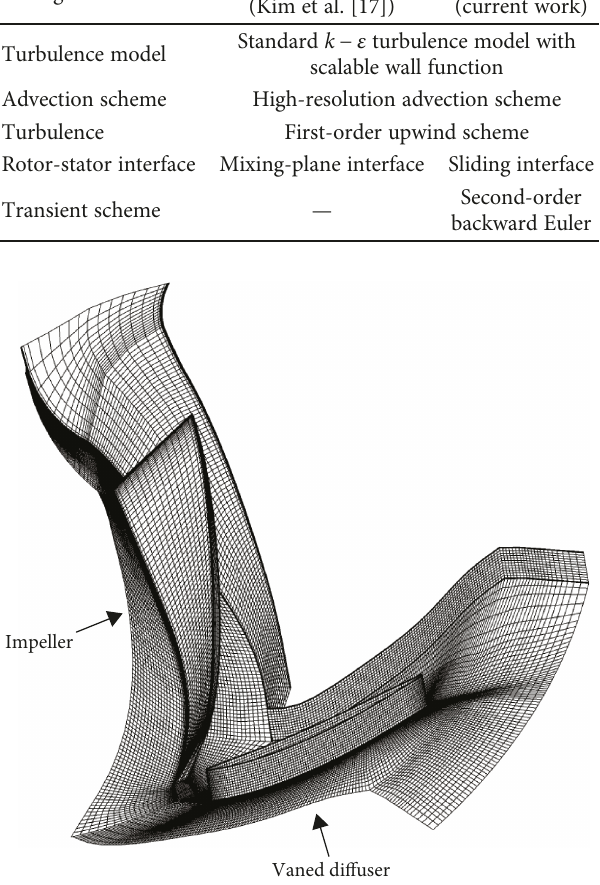
Figure 2: Computational mesh for the centrifugal compressor stage.